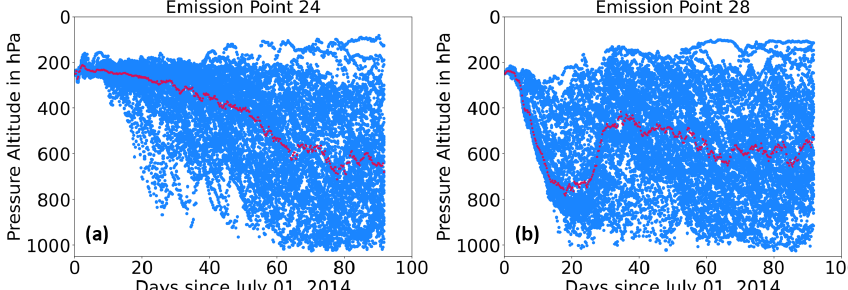
Figure 5. Temporal evolution of the air parcel trajectory pressure altitude of median trajectories (red) based on 50 Lagrangian paths (blue) in (a) emission point 24 and in (b) emission point 28 for N. America for July–September 2014. The trajectories of the remaining regions are included in the supplementary figures in Maruhashi et al. (2022a). Figure S7 shows all 28 emission points for N. America during July– September